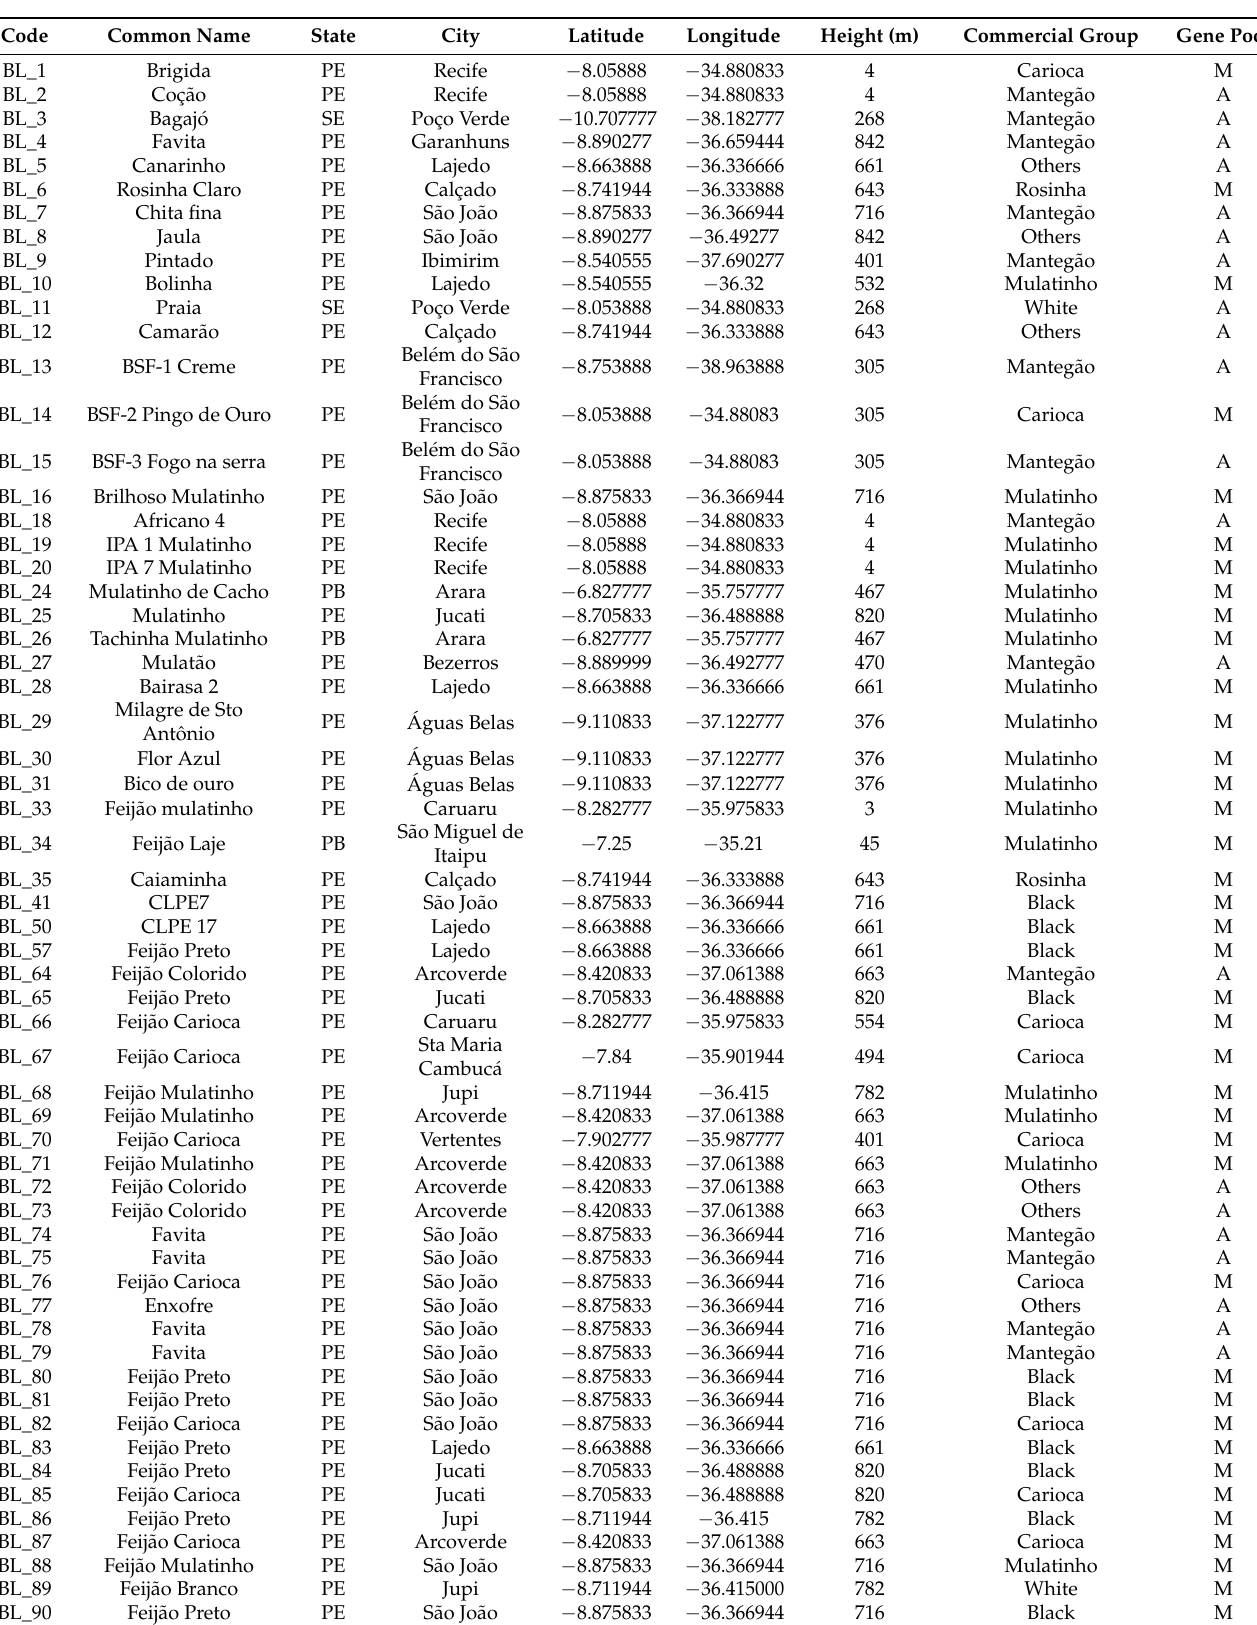
Table 4. Identification of the 110 common bean accessions from Brazil evaluated in this study.